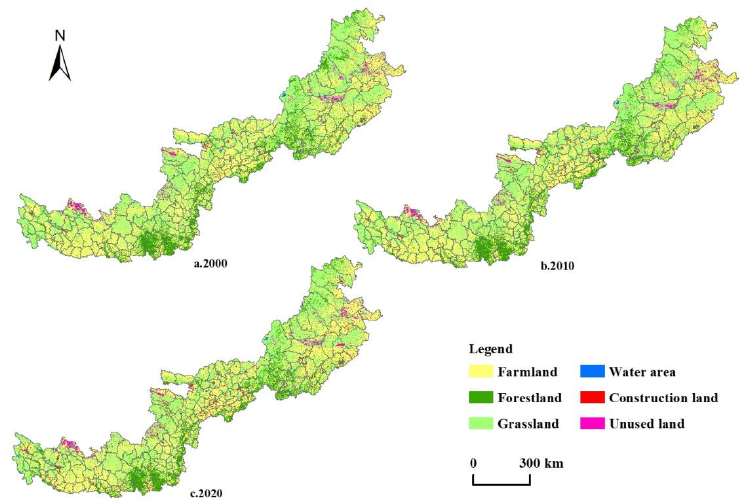
Figure 2. Land-use maps within AENC in 2000, 2010, and 2020. Table 2. Classification and area proportion of digital elevation model (DEM), slope, and terrain re- lief. Elevation Slope Terrain relief Rank